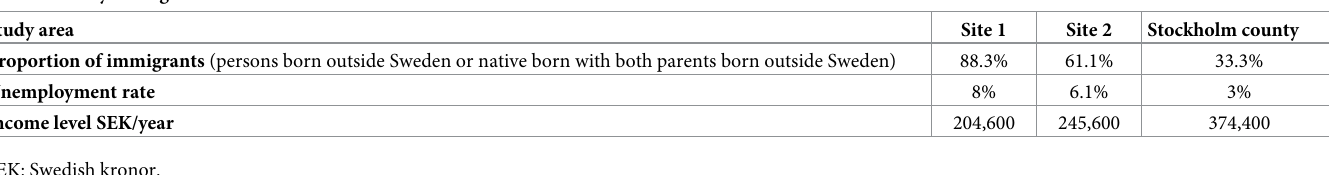
Table 1. Study setting